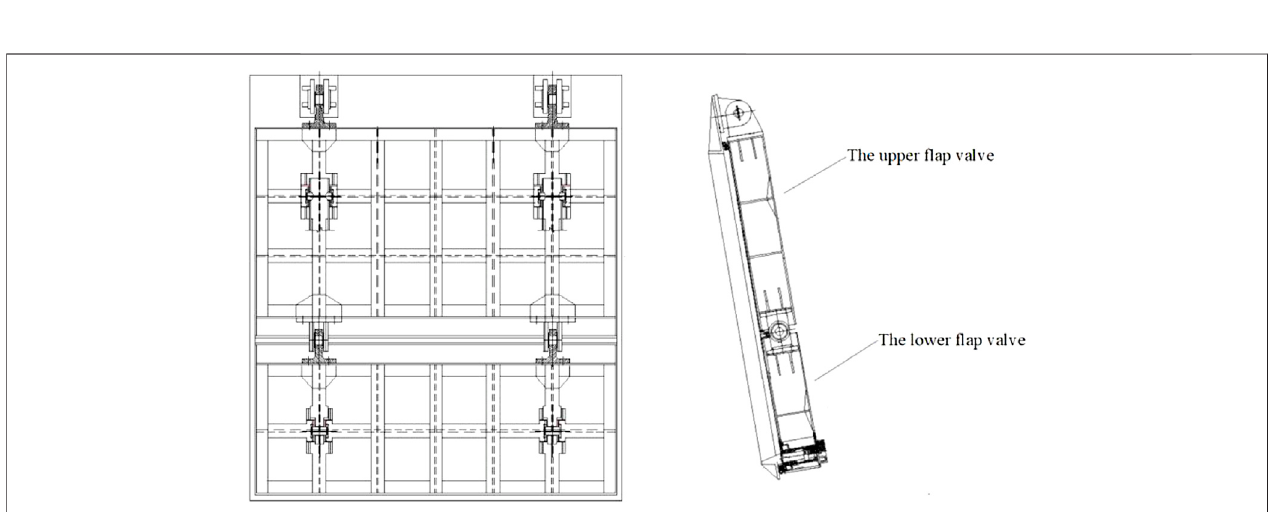
FIGURE 1 | Diagram of the model and cross-section: (A) diagram of the fl ap valves section and (B) diagram of the culvert section.